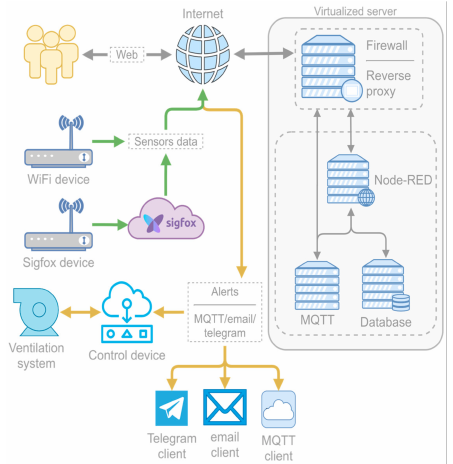
Figure 1. The architecture of the air quality control